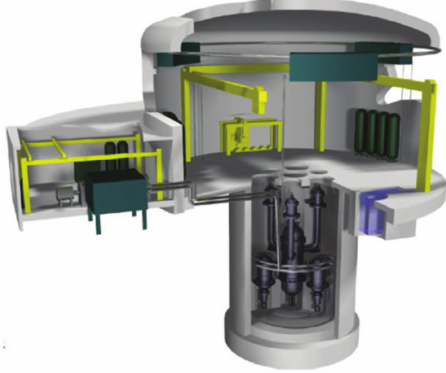
Fig. 9. ALLEGRO reactor